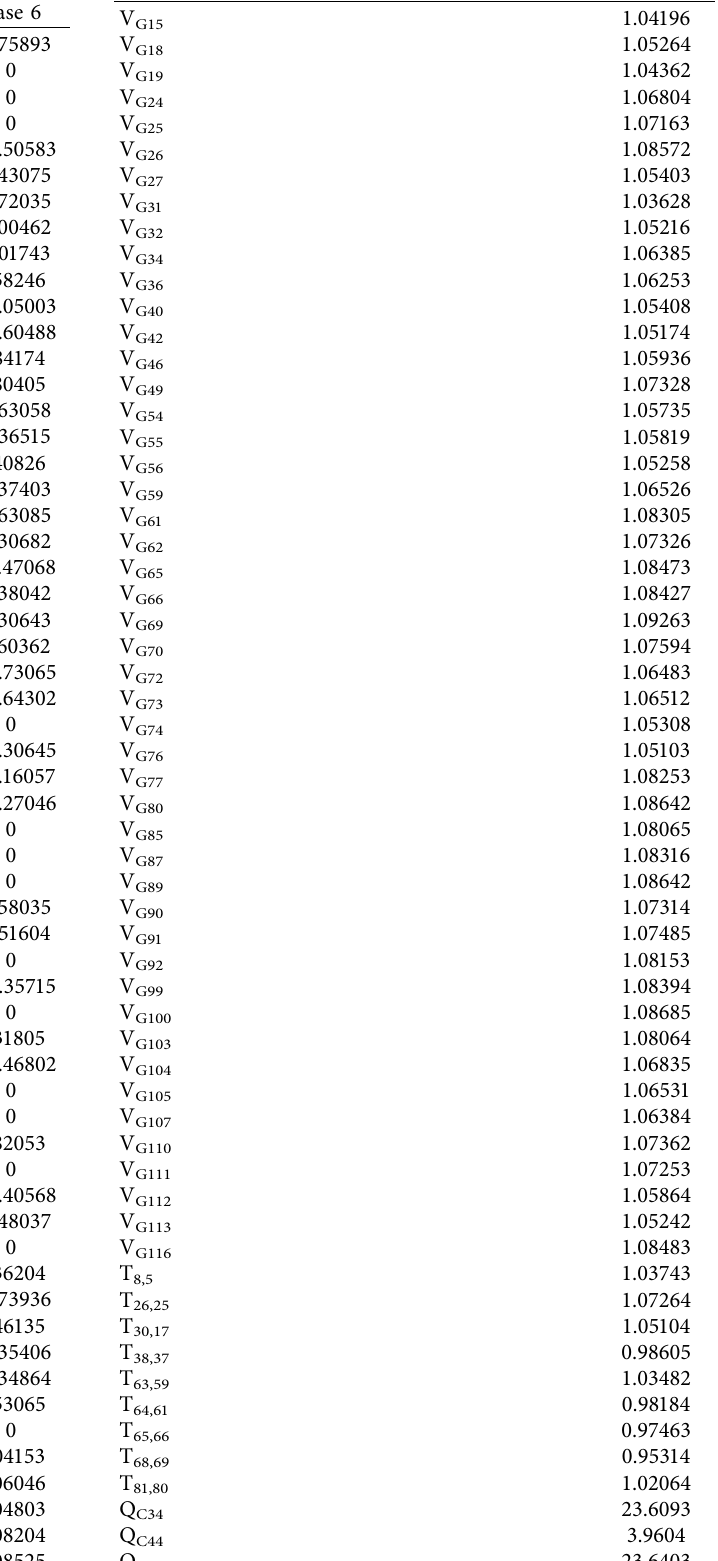
Table 9: Optimum solution obtained for case 6 using the chaotic Rao-2